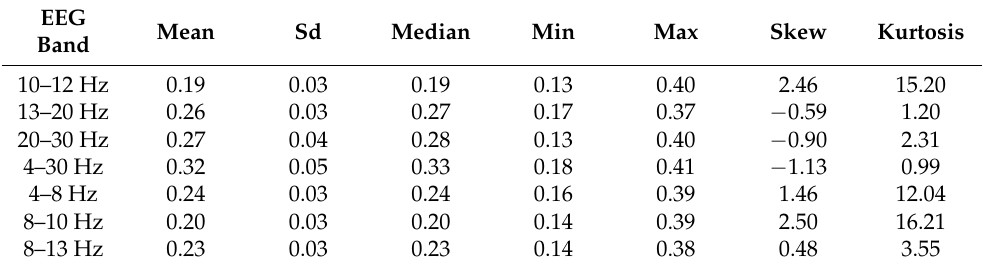
Table 3. Descriptive statistics of cluster coefficient metric for narrow EEG bands.